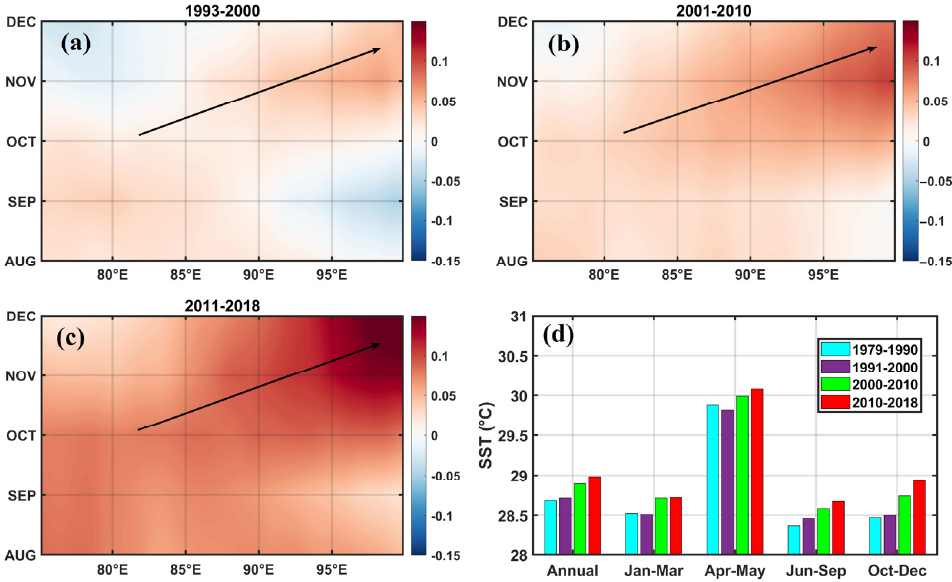
Figure 7. ( a – c ) SSHA decadal variation in longitude versus time plot averaged for the latitudinal band ( − 2.5° S to 2.5° N). The black arrow represents the propagation of the Kelvin wave. ( d ) Decadal variation of SST in the southeastern Arabian Sea for different seasons.